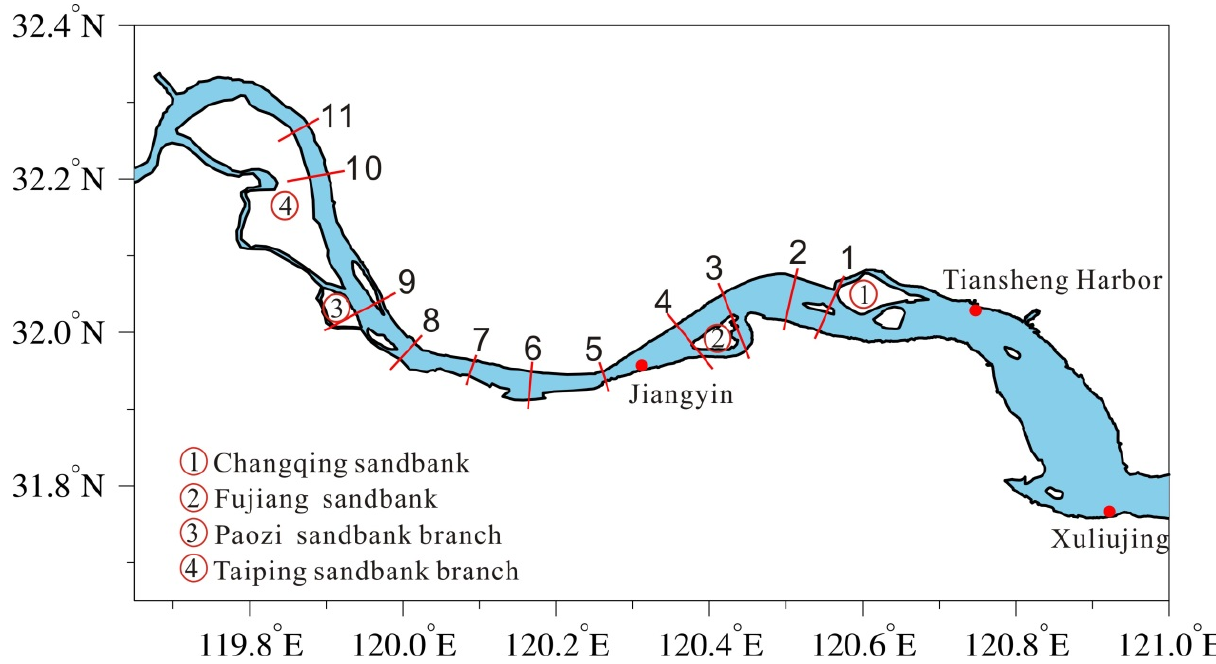
Figure 6. Tidal current limits under various guarantee rates of river discharge in the Changjiang River’s estuary in the flood season. The locations of sections 1–11 are the tidal current limits corresponding to the guarantee rates of 5–95% of river discharge.